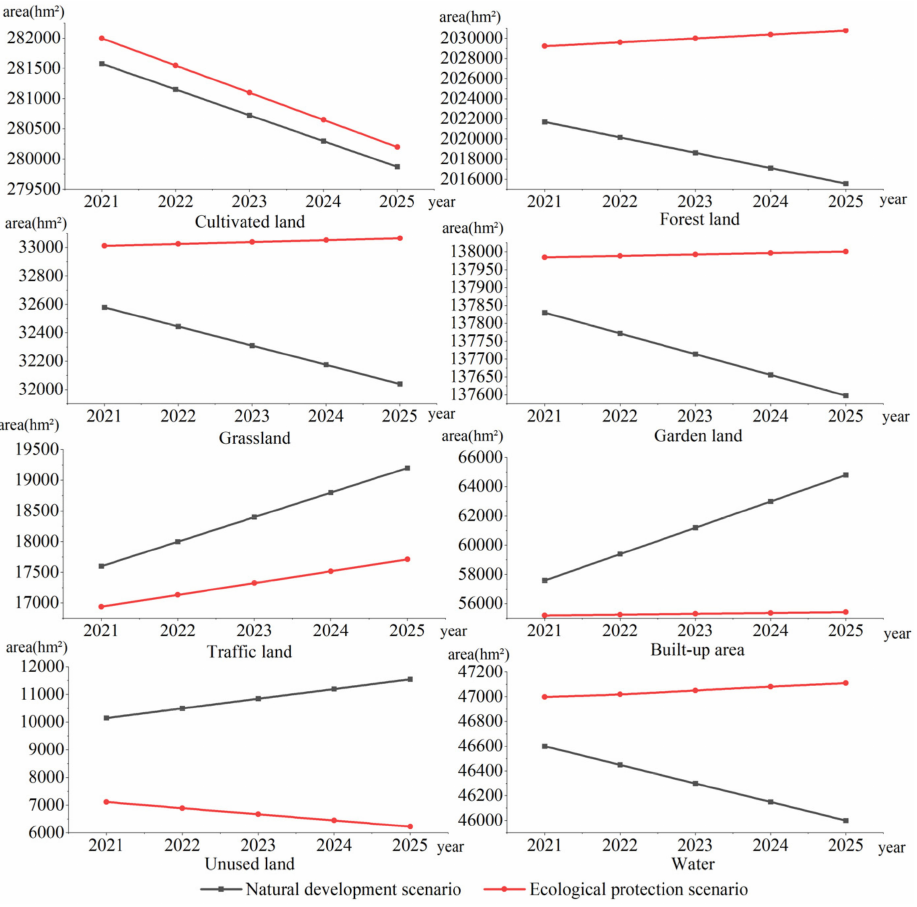
Figure 2. Prediction of land-use demand from 2020 to 2025 under the natural development scenario and the ecological protection